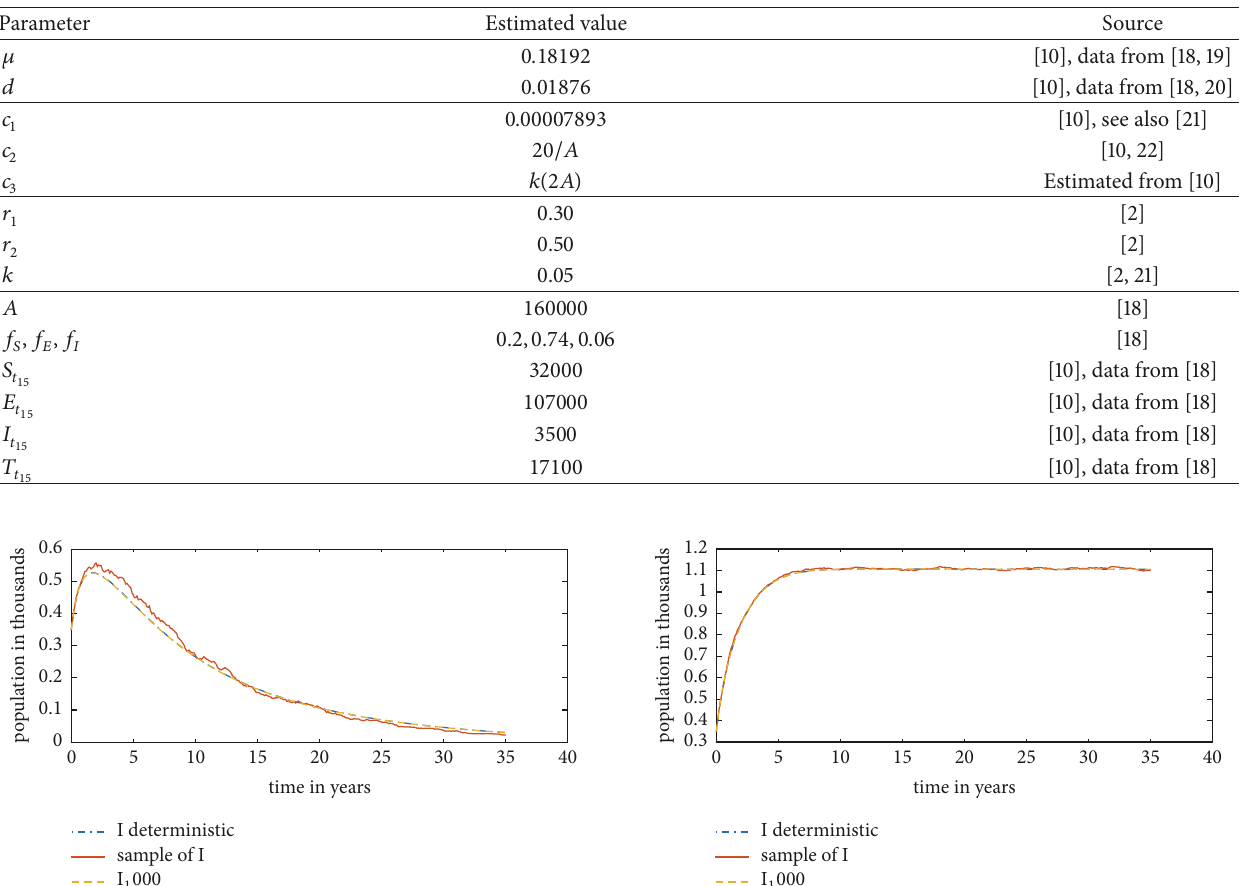
Table 1: Model parameters and initial conditions.